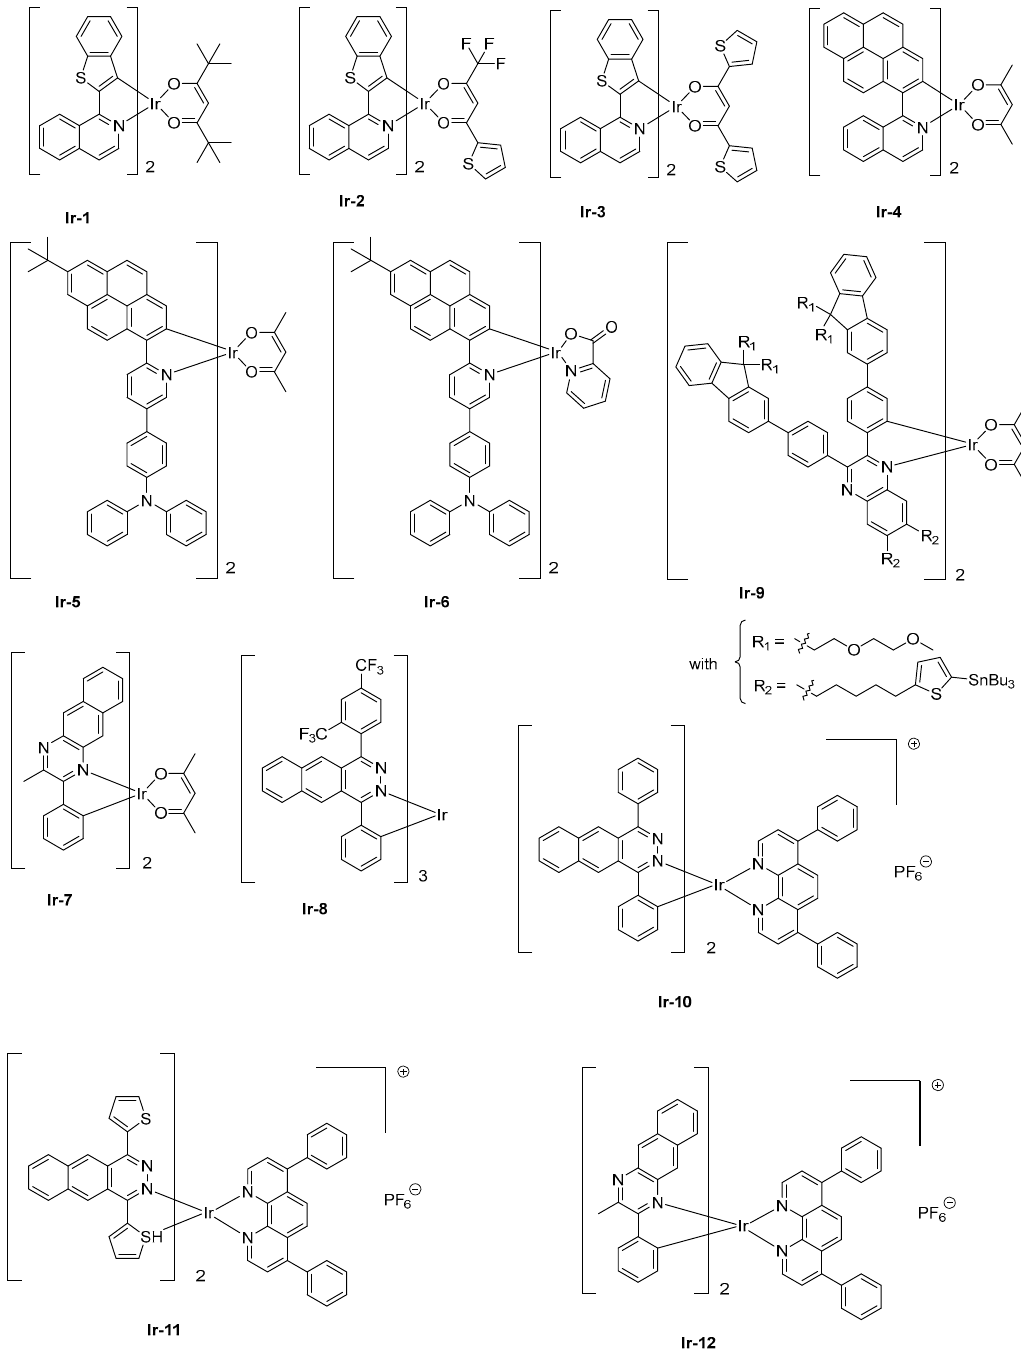
Figure 3. Ir-based near-infrared (NIR) emitters for light-emitting diodes.